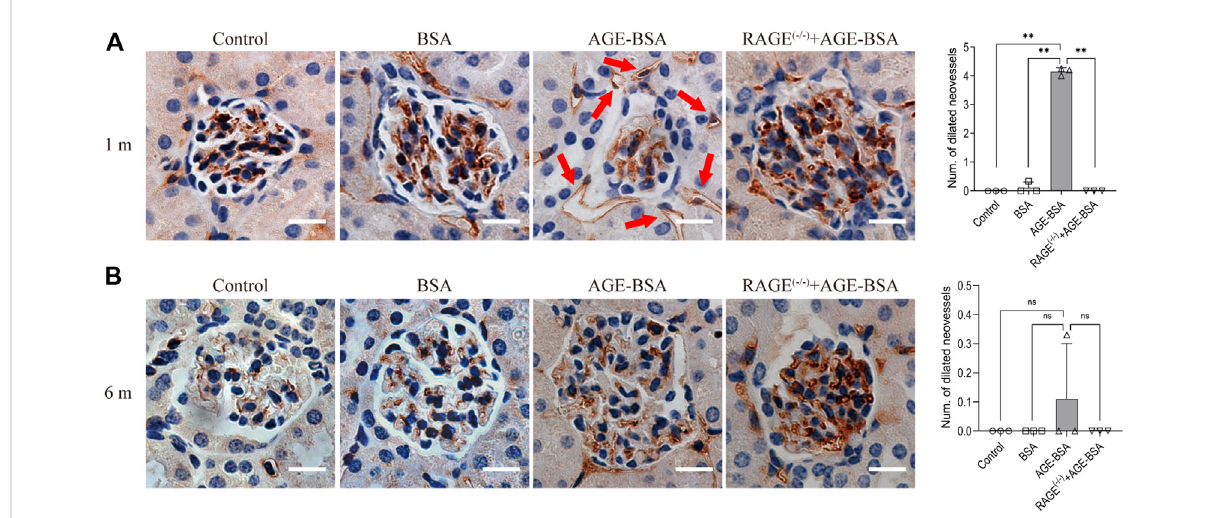
FIGURE 1 AGE-BSA induces RAGE-mediated renal angiogenesis in the early stage of stimulation. Representative images of CD34 staining of glomeruli after AGE-BSA treatment for 1 m (A) and 6 m (B) are shown, and the number of dilated vessels around glomeruli was counted and analyzed. Arrow: dilated neovessels around the renal capsule. Scale bar = 20 μ m. n = 3, ** p < 0.01, ns: no signi fi cance.